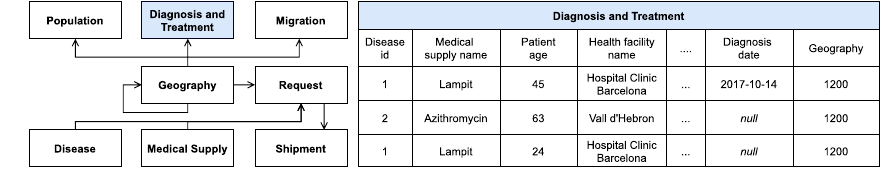
Fig. 6 Example of the schema for the tables in Formatted Zone for the WIMEDS